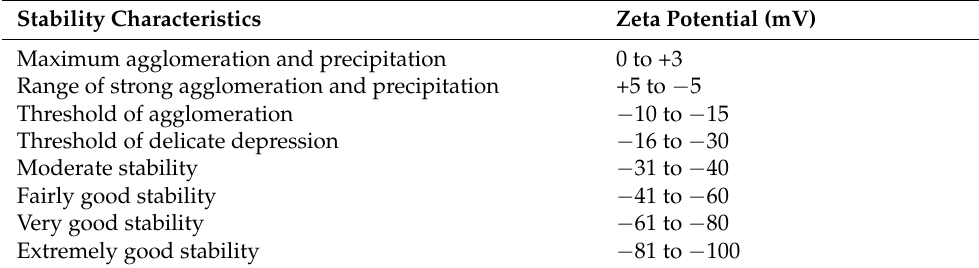
Figure 8. Graphical representation of zeta potential and globule size. Table 3. Relationship between zeta potential and emulsion